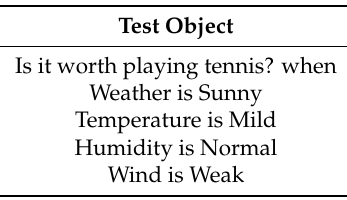
Table 7. The demonstration problem to be solved.